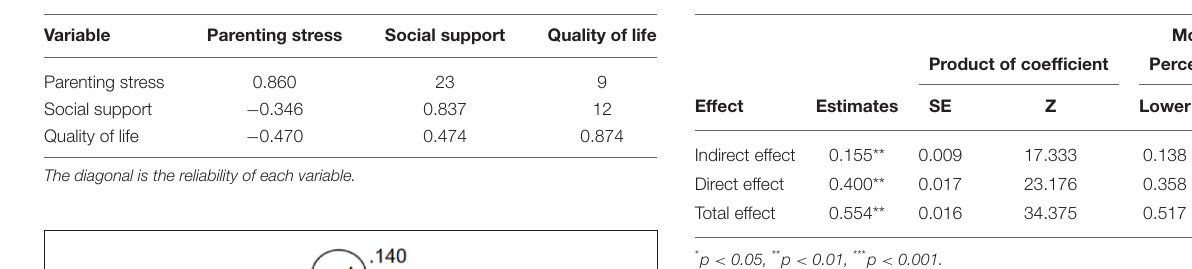
TABLE 7 | Pooled correlation matrix under different sociocultural background.